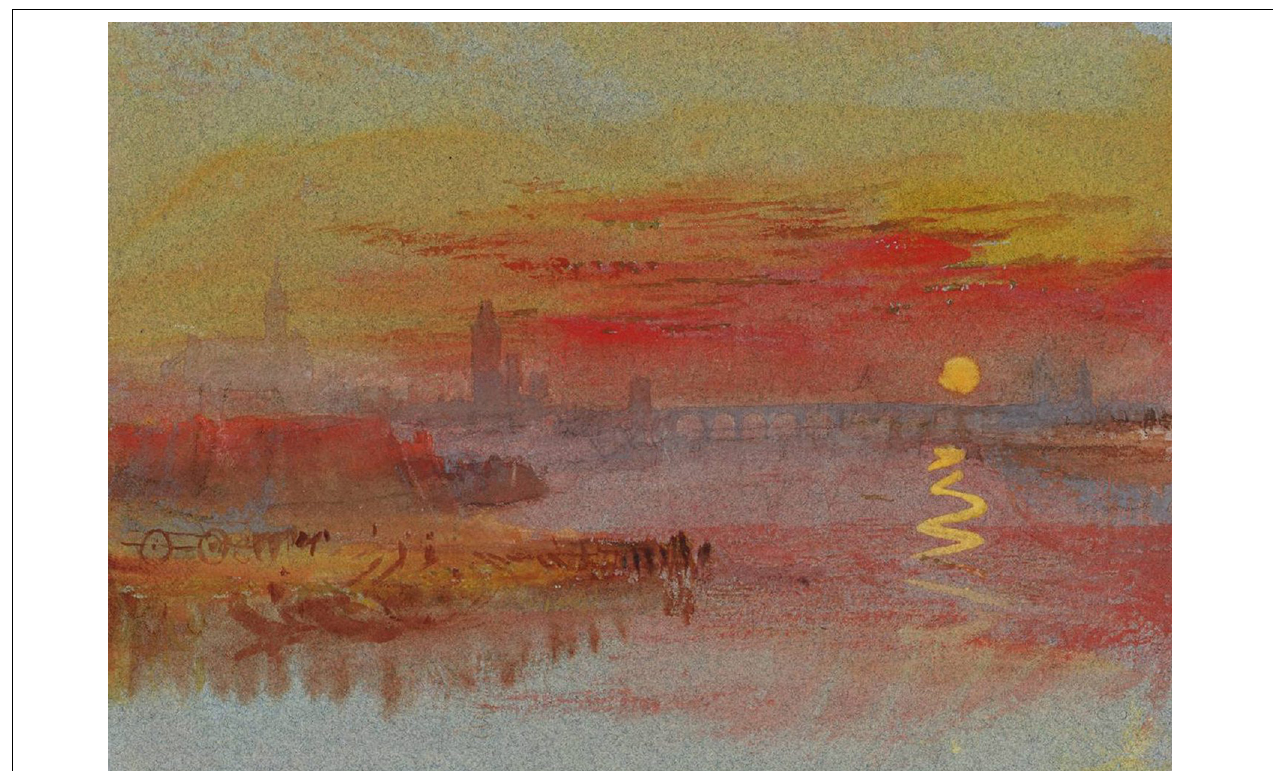
FIGURE 1 | In the nineteenth century, painters like Turner effectively exploited color, saturation, and luminance effects to suggest figure and ground, as here in “Sunset on